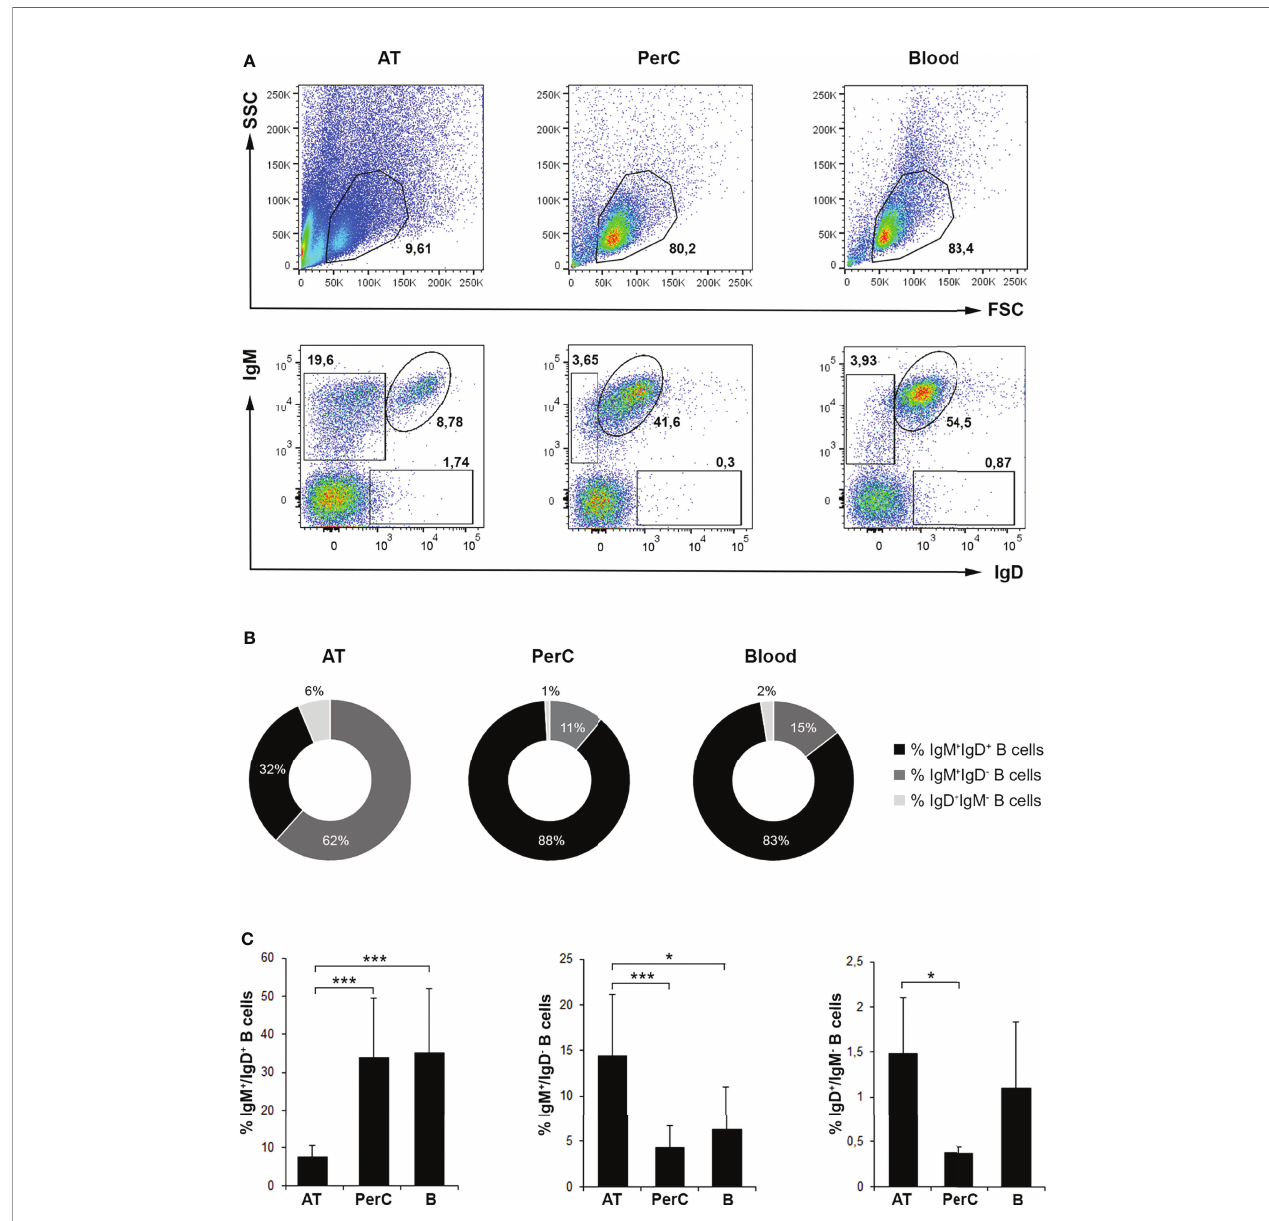
FIGURE 1 | Flow cytometry analysis of B cell subsets in rainbow trout AT compared to peritoneal cavity (PerC) and blood leukocyte populations. Leukocytes isolated from AT, PerC and blood were labeled with mAbs against trout IgM and IgD and analyzed by fl ow cytometry. (A) Representative dot plots from each tissue are shown. Upper panels correspond to dot plots showing the forward scatter and side scatter (FSC/SSC) pro fi le of isolated leukocytes in which the lymphoid gates were de fi ned. Lower panels correspond to dot plots showing IgM and IgD fl uorescence intensities de fi ning the different B cell subpopulations in each tissue (IgM + IgD + ; IgM + IgD - ; IgD + IgM - ). (B) Pie charts showing the ratio of the three different subpopulations of IgM/D-bearing B cells in each tissue. (C) Graphs showing the mean percentages of B cell subsets among total lymphoid cells in each tissue (mean + SD; n = 8 fi sh). AT, Adipose tissue; PerC, Peritoneal cavity; B, Blood. Asterisks denote signi fi cantly different values between indicated groups (*p ≤ 0.05 and ***p ≤